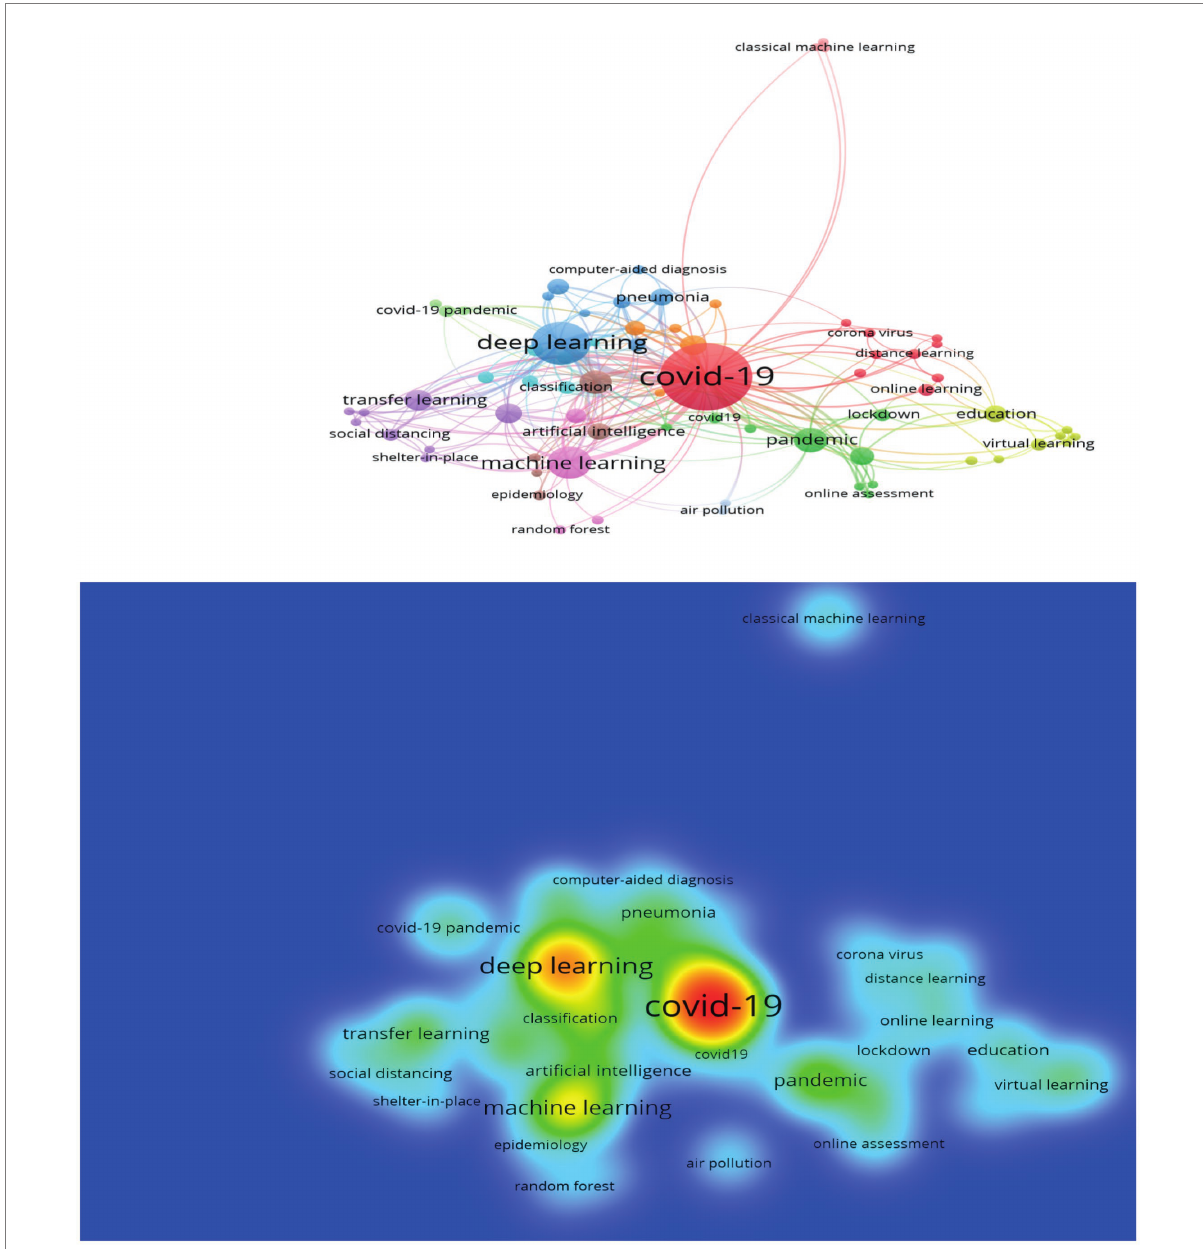
FIGURE 6 The network and density of keywords depend on Science Direct (VOSviewer